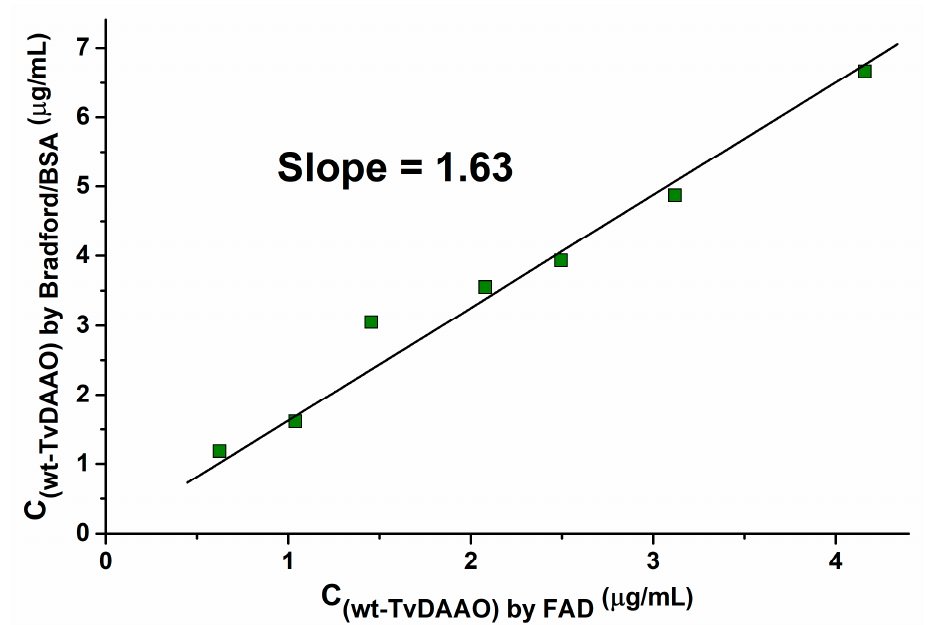
Figure 1. Correlation between wt-TvDAAO concentrations measured with the Bradford method with bovine serum albumin (BSA) as a standard and FAD extinction coefficient (0.1 M potassium phosphate buffer pH 8.0).